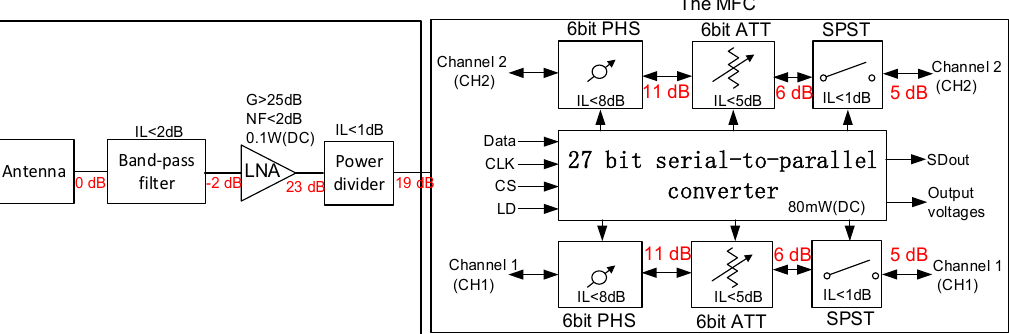
Figure 1. The diagram of the actual application.